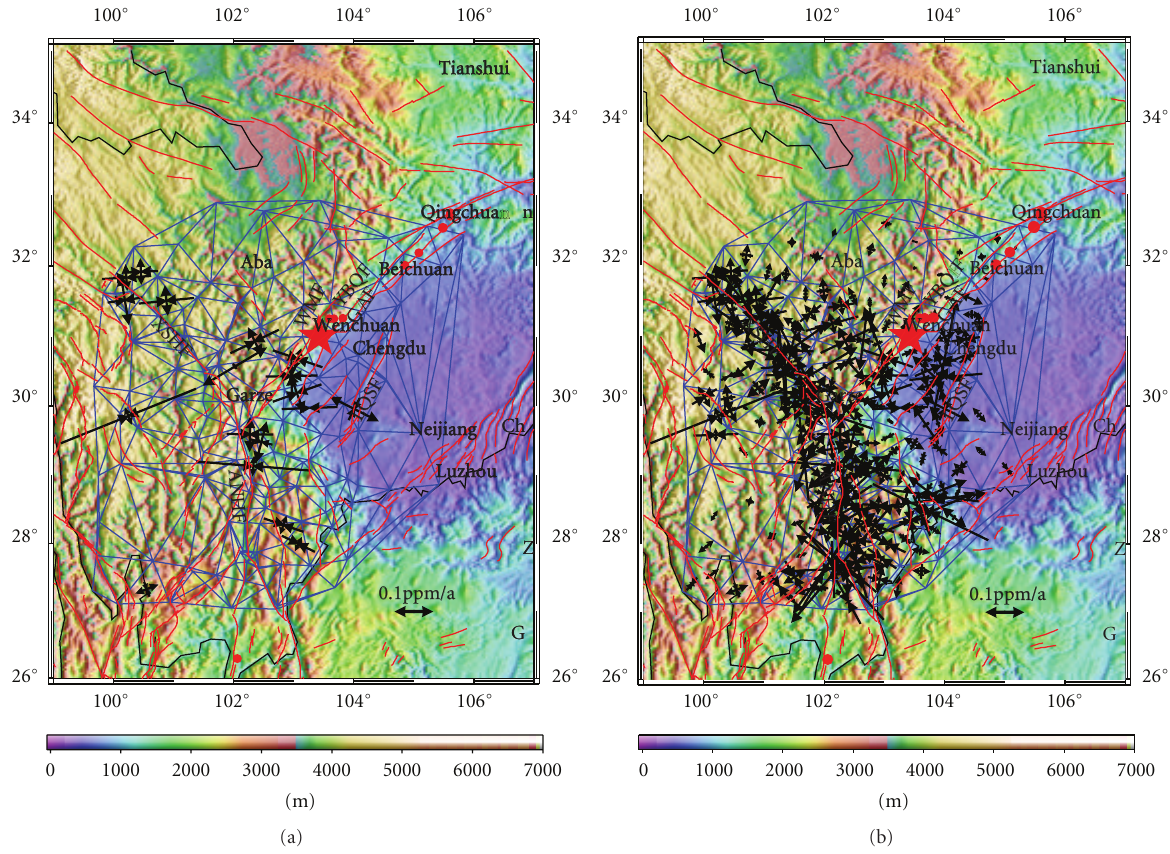
Figure 3: Principal strain rates distribution before Wenchuan earthquake. Double arrows show the principal strain rate labeled at the center of individual triangles. Red circles represent the main- and aftershocks with magnitude greater than 6.0. The Delaunay triangle network is formulated with GPS points as their vertexes. The red lines show the active faults based on [2]. (Only the principal strain rates passed the drawn in